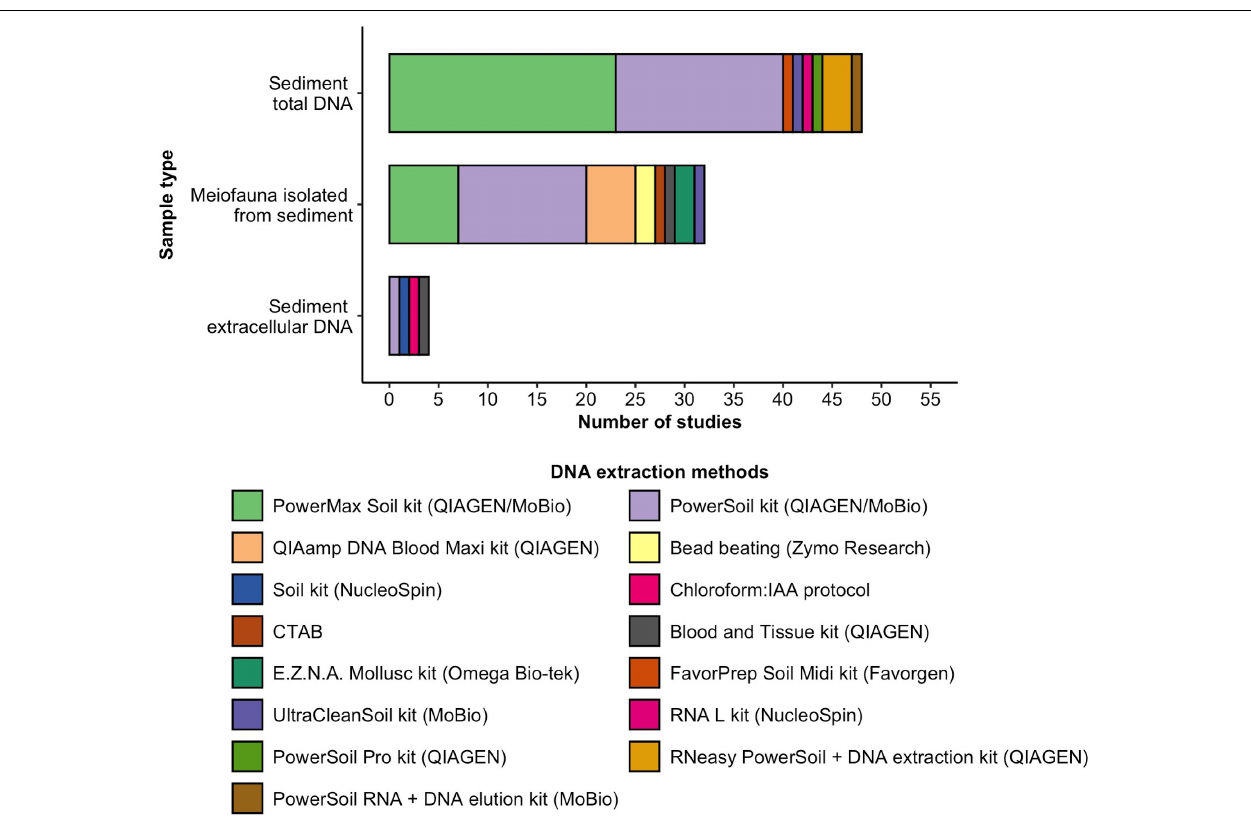
FIGURE 1 | DNA extraction kits or protocols used in meiofaunal community metabarcoding studies for the extraction of DNA directly from sediment, isolated meiofauna, or sediment extracellular